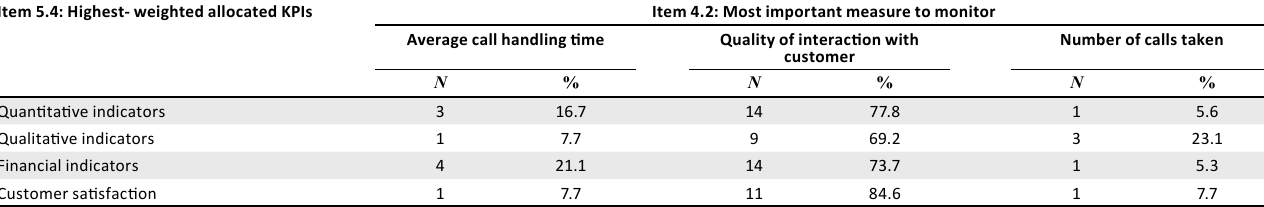
TABLE 14: Cross tabulation of the highest-weighted allocated KPIs and the most important measures in monitoring calls . Item 5.4: Highest- weighted allocated